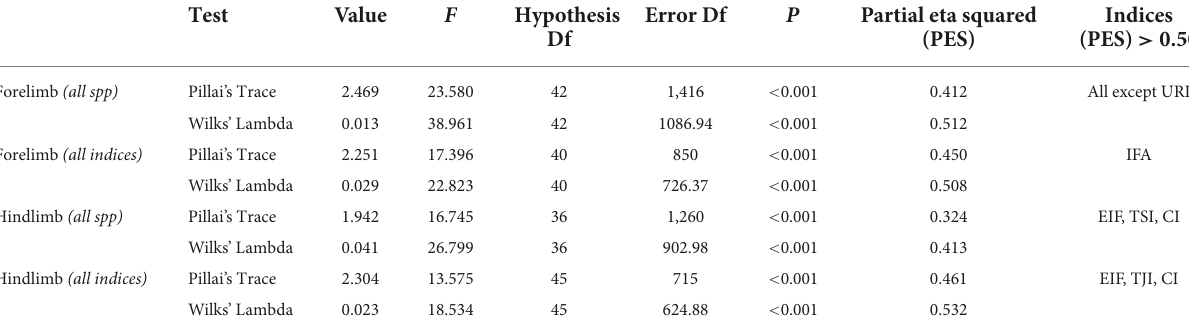
TABLE 4 MANOVAs on morpho-functional indices of the forelimb and hindlimb, including all species and all indices. Test Value F Hypothesis Error Df